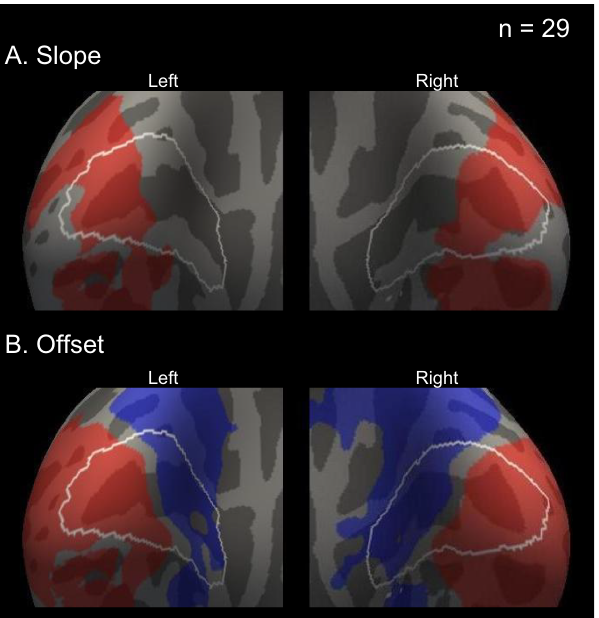
Fig 6. Significant regions of slope and offset by group analysis (n = 29). The significant slope (A) and offset clusters (B) were overlaid on the standard inflated brain surface. Red and blue regions indicate positive and negative contrast, respectively. Brain surfaces are shown from a posterior/medial viewpoint. White lines on the brain surfaces indicate the border of V1. Statistical significance level was set at cluster-wise corrected P < 0.05. https://doi.org/10.1371/journal.pone.0259243.g006 the BOLD slope or offset coefficients obtained by the parametric ROI analysis and the individ- ual characteristics of age, MMSE, or UFOV test performance (Table 4). All of the correlations were not significant.